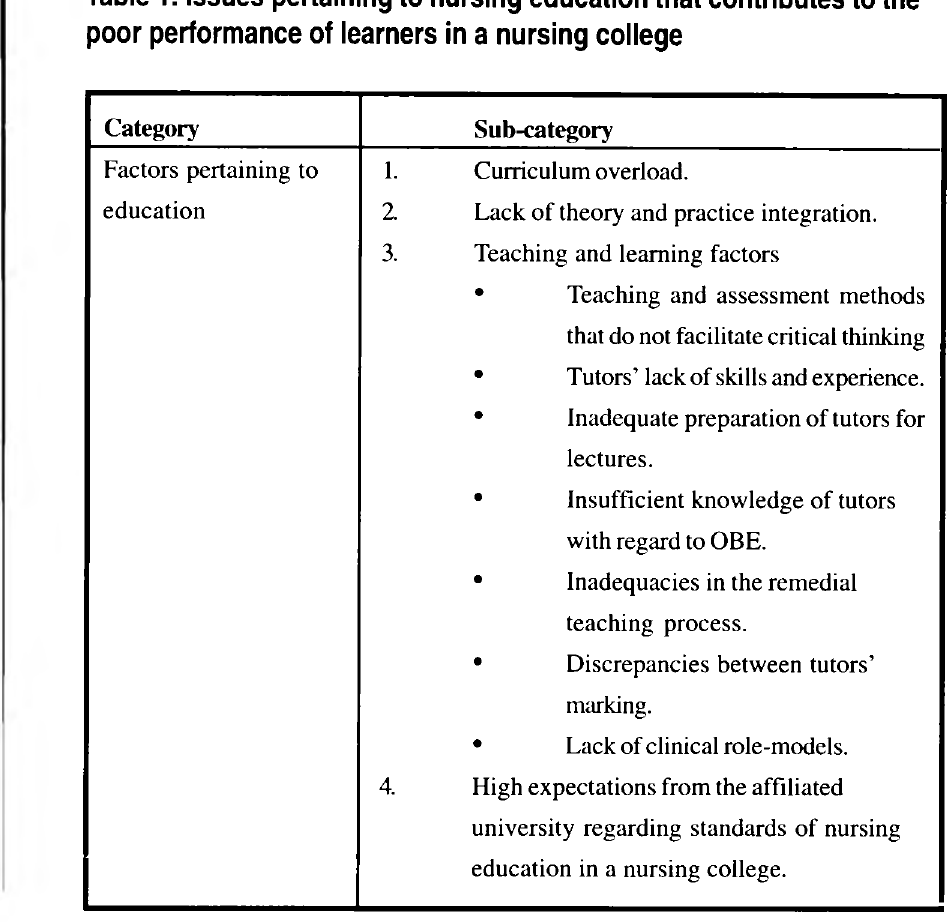
Table 1: Issues pertaining to nursing education that contributes to the poor performance of learners in a nursing college